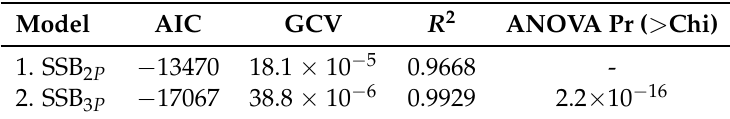
Table 3. Overall statistical performance of the two tested approaches. A verified reduction of Akaike Information Criterion (AIC) and Generalized Cross Validation (GCV) from SSB 3 P relative to SSB 2 P , indicating a more optimized model performance when a third predictor is considered. Coefficient